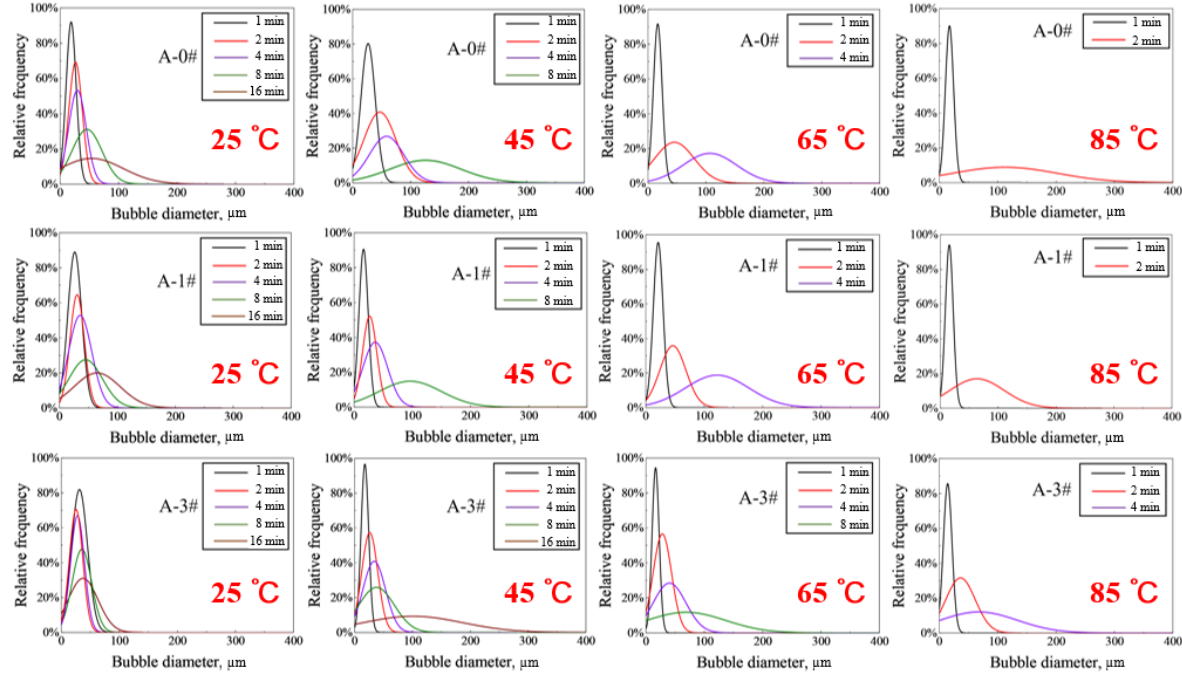
Figure 7. Relative frequency of bubble size distribution of A-0#, A-1#, and A-3#. In order to quantify the bubble coarsening process, the dimensionless average area ( A ) of individual bubbles at different temperatures is measured and plotted versus time in